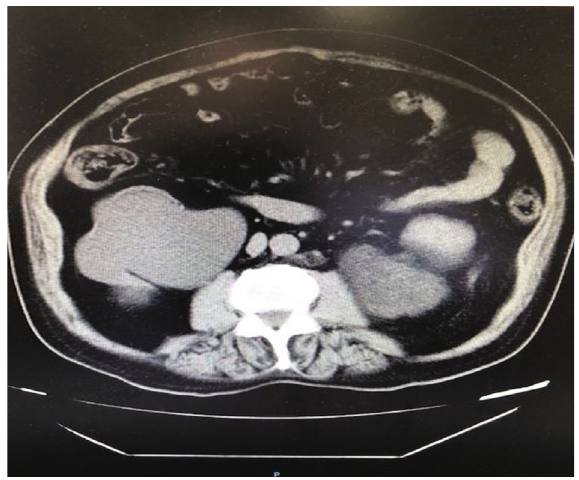
Figure 2: CT of November 2019 showing the important growth of the mass located between the left kidney and the psoas